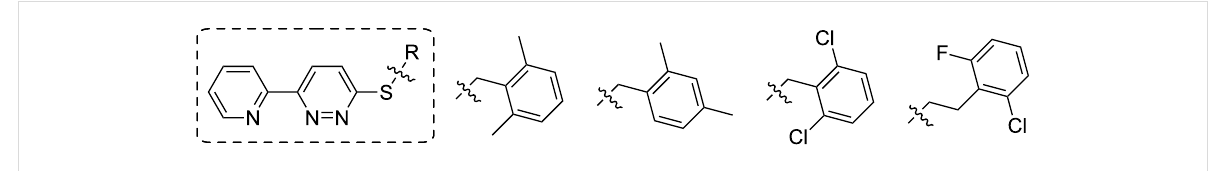
Figure 4: Thiopyridazines developed to increase EAAT2 protein levels.